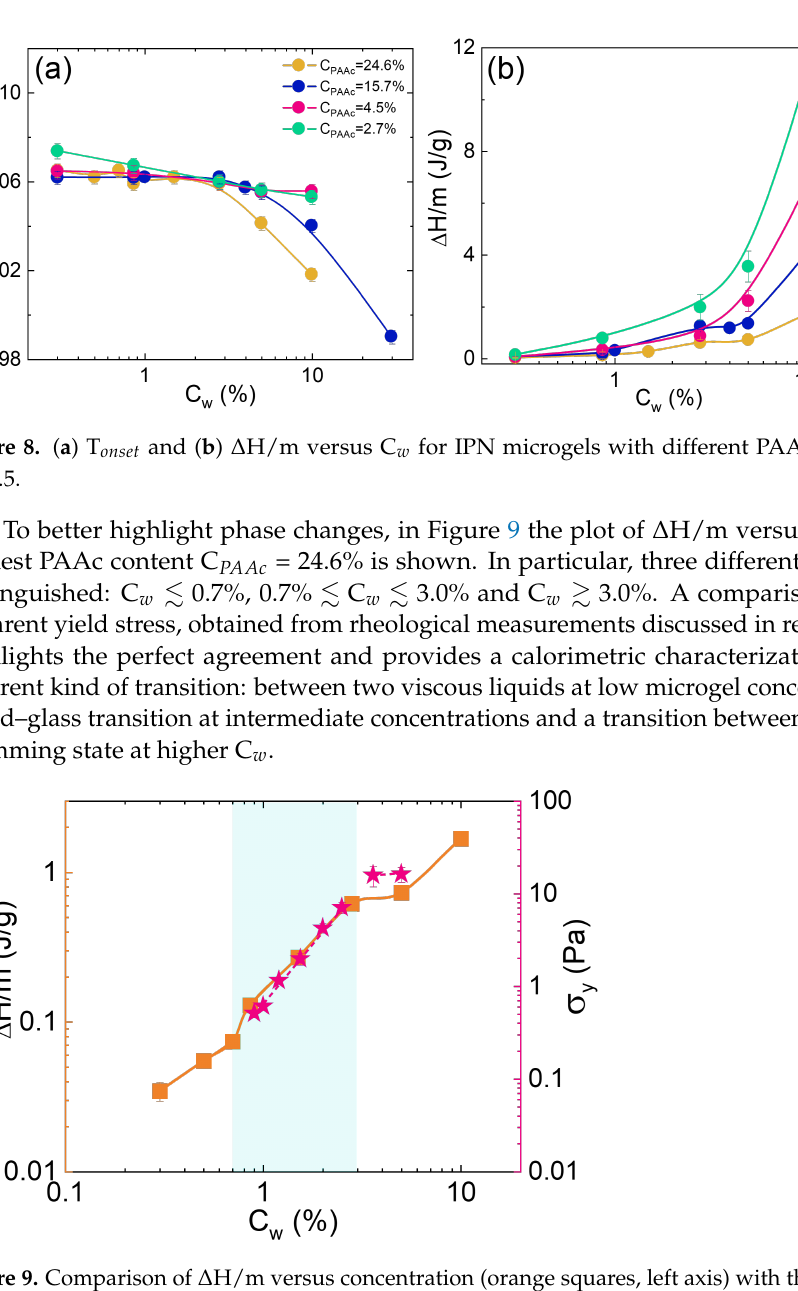
Figure 9. Comparison of ∆ H/m versus concentration (orange squares, left axis) with the yield stress obtained from the rheological measurements (pink stars, right axis) reported in reference [75] for an IPN at C PAAc = 24.6% and pH